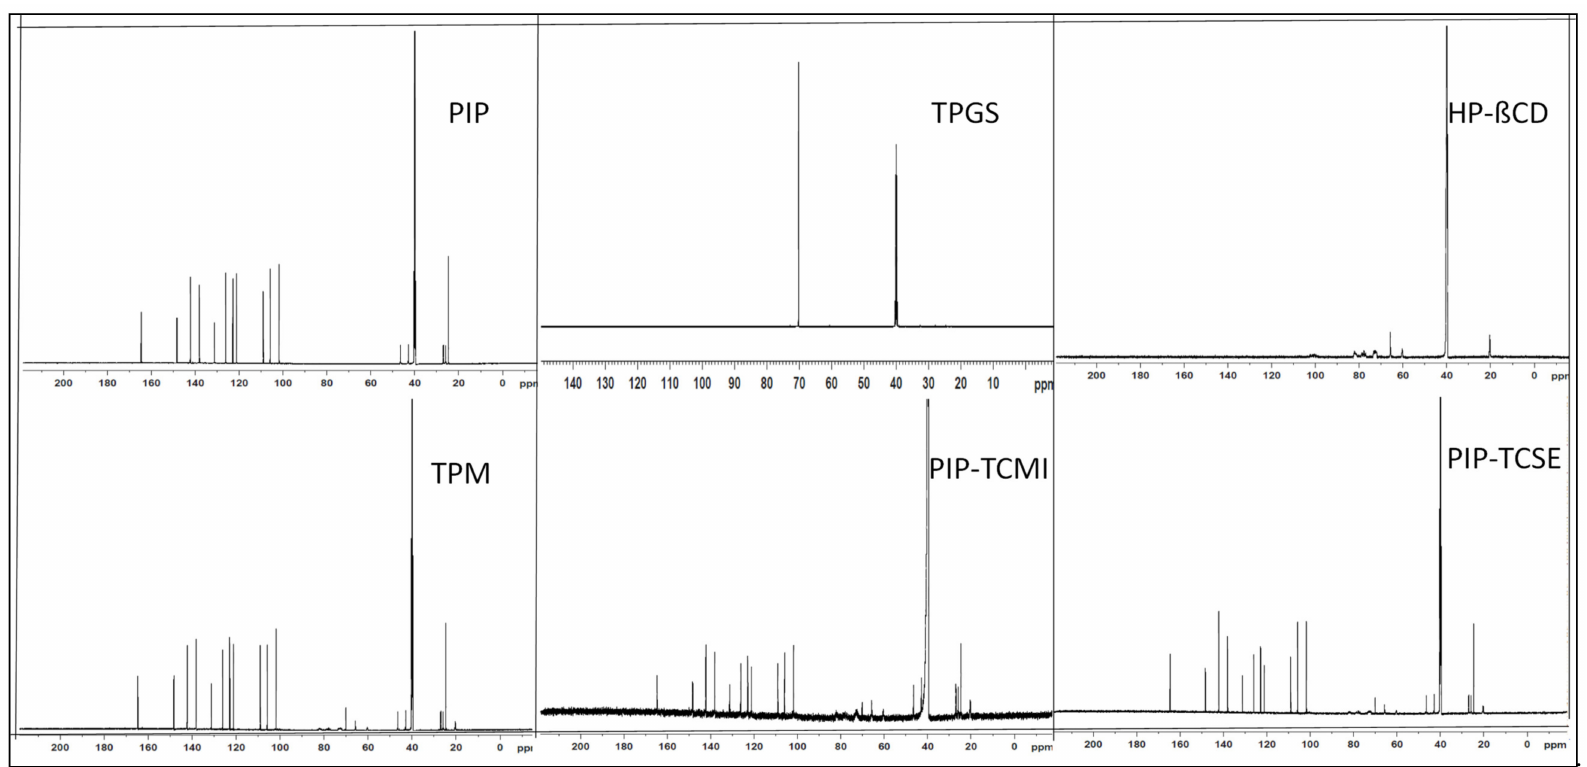
Figure 9. 13 C NMR spectra of pure piperine, HP β CD, TPGS, PIP ternary physical mixture, piperine ternary inclusion complex (microwave irradiation), and piperine ternary inclusion complex (solvent